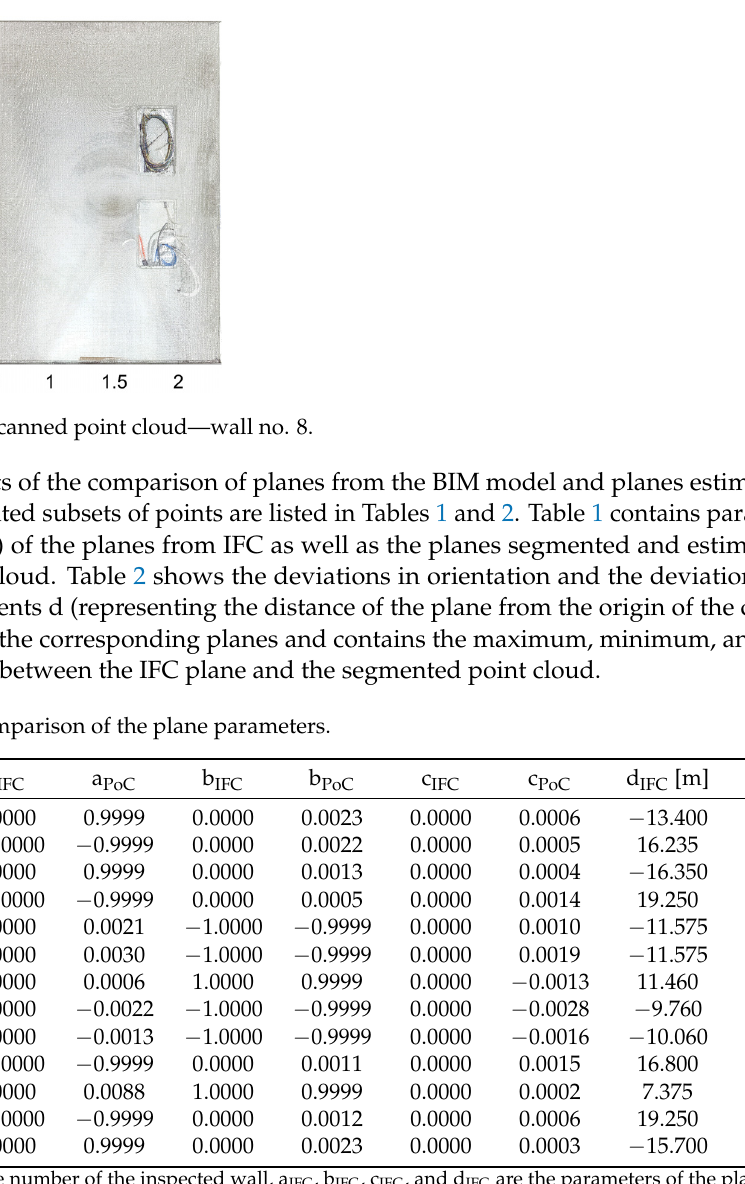
Table 2. Deviations between the BIM model and the as-built model.